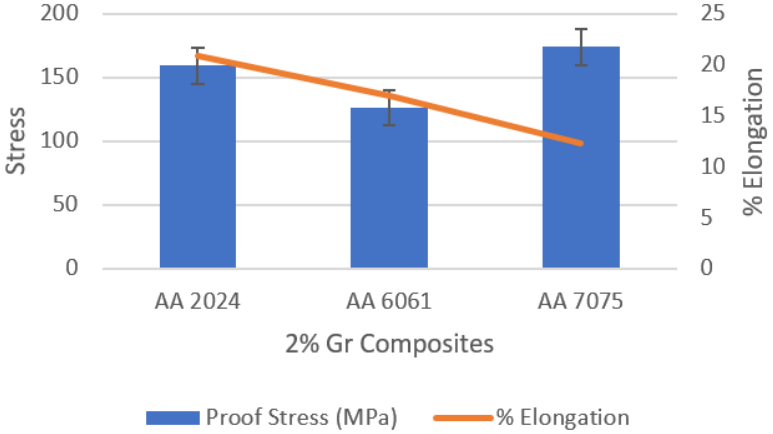
Figure 20. Trend of proof stress and elongation.